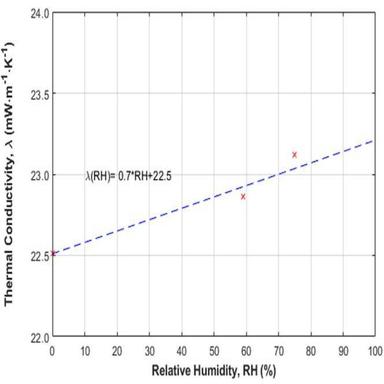
Thermal Conductivity λ against RH for the aerogel composite.